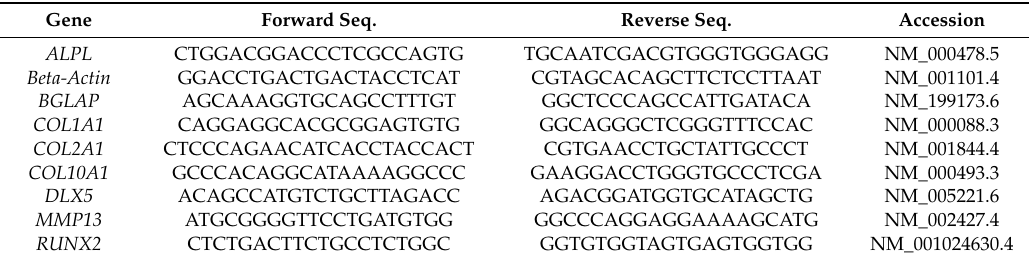
Table 1. List of forward and reverse primers, in 5 (cid:48) to 3 (cid:48) orientation, used for RT-qPCR. Gene Forward Seq.